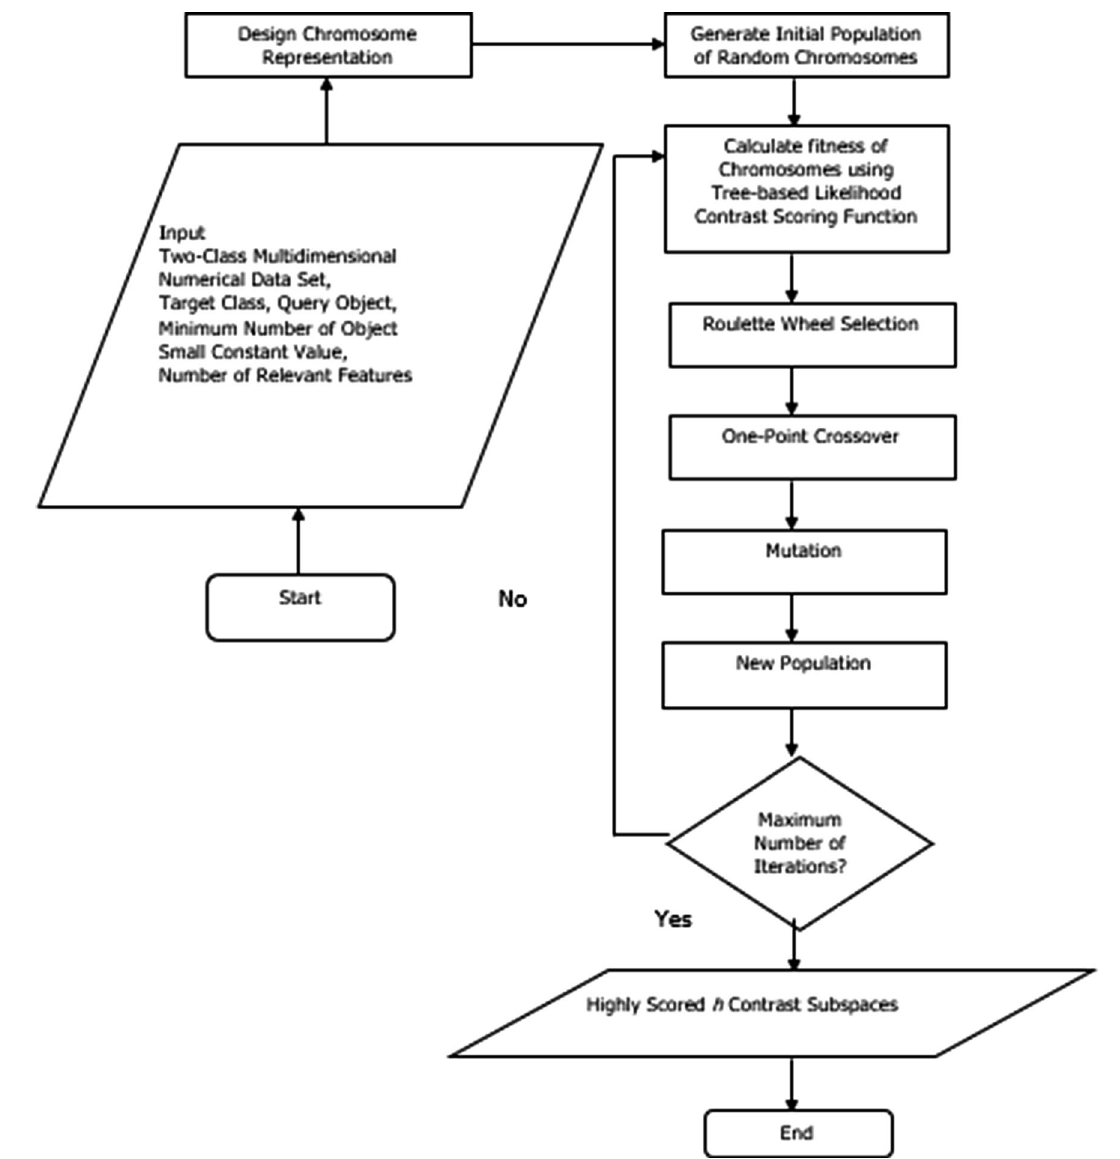
Fig. 1 Framework of genetic tree-based contrast subspace mining method